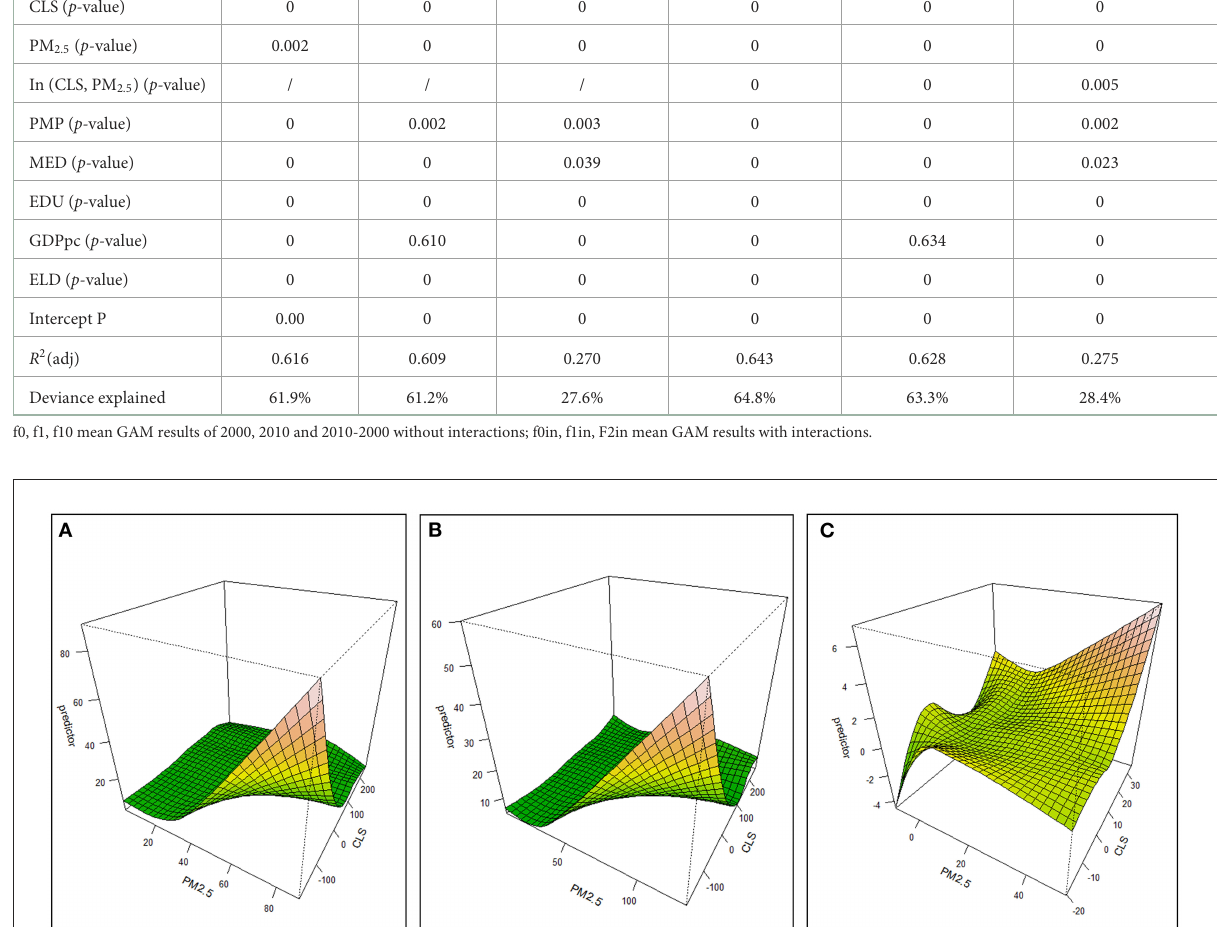
Compared to the distribution in eastern China, which had a higher level of economic and medical development, the impact